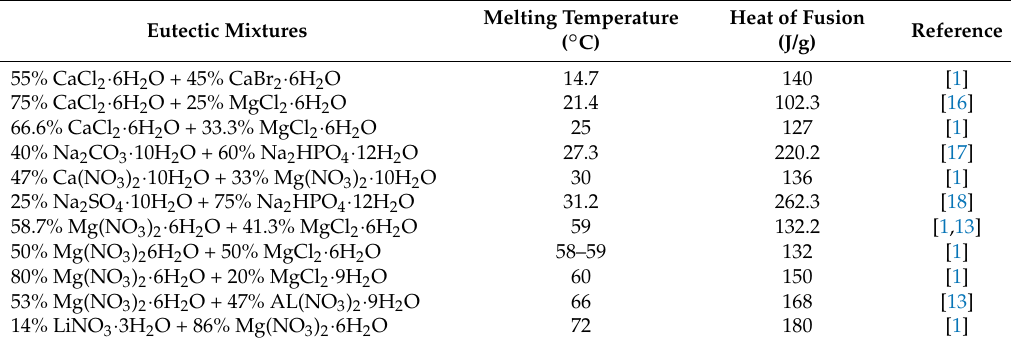
Table 2. Melting temperatures and heat of fusion of some eutectic